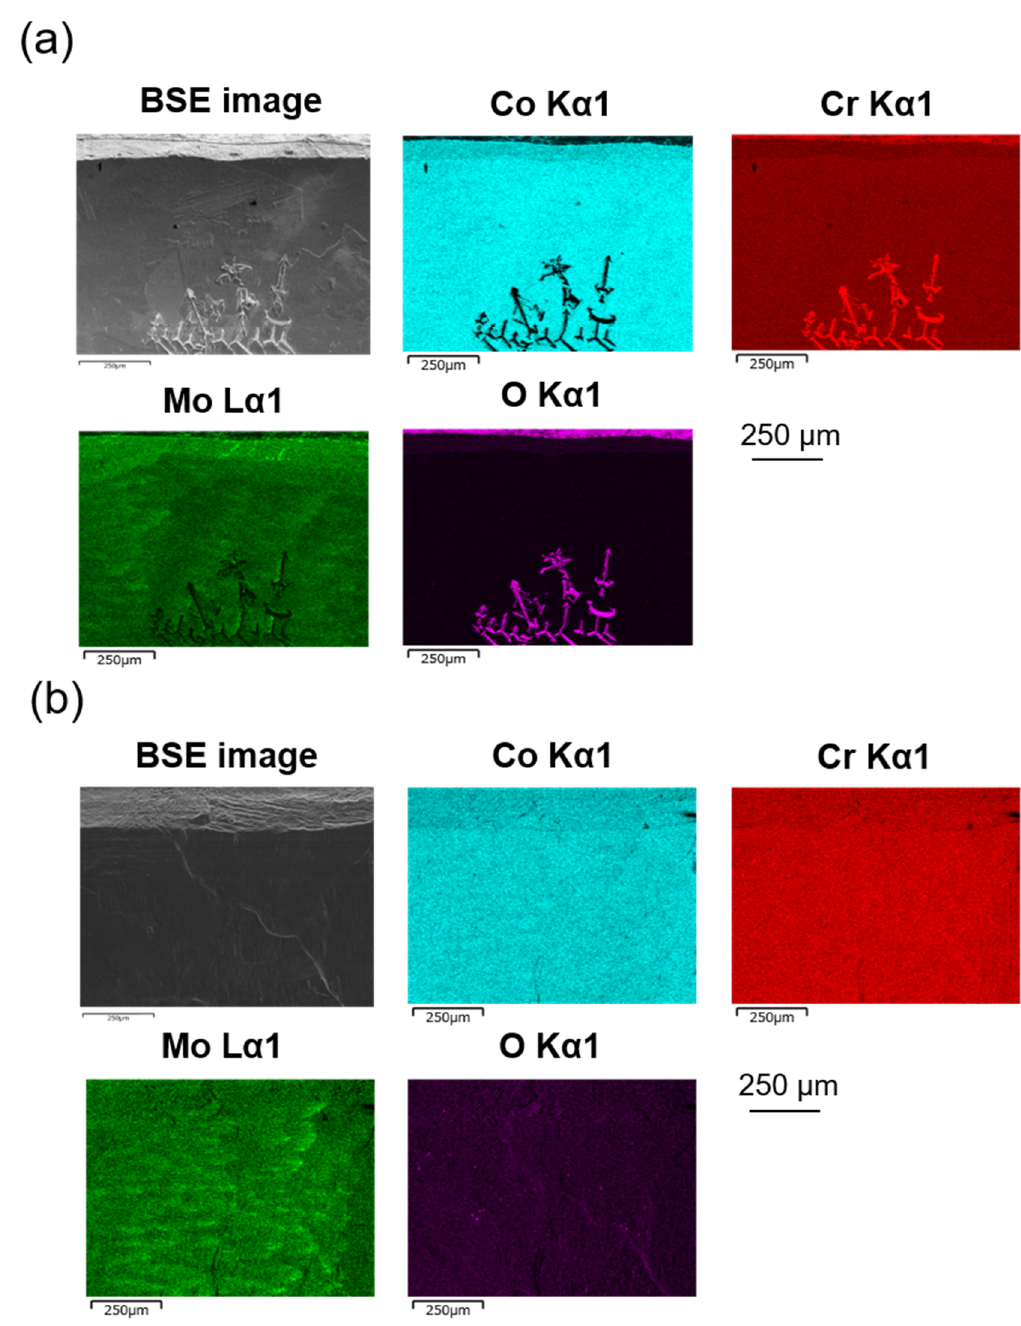
Figure 2. Back-scattering electron (BSE) images and element mappings on polished surfaces parallel to the growth direction for the Co-Cr-Mo fibers fabricated under ( a ) Ar and ( b ) Ar + 3%H 2 atmosphere.